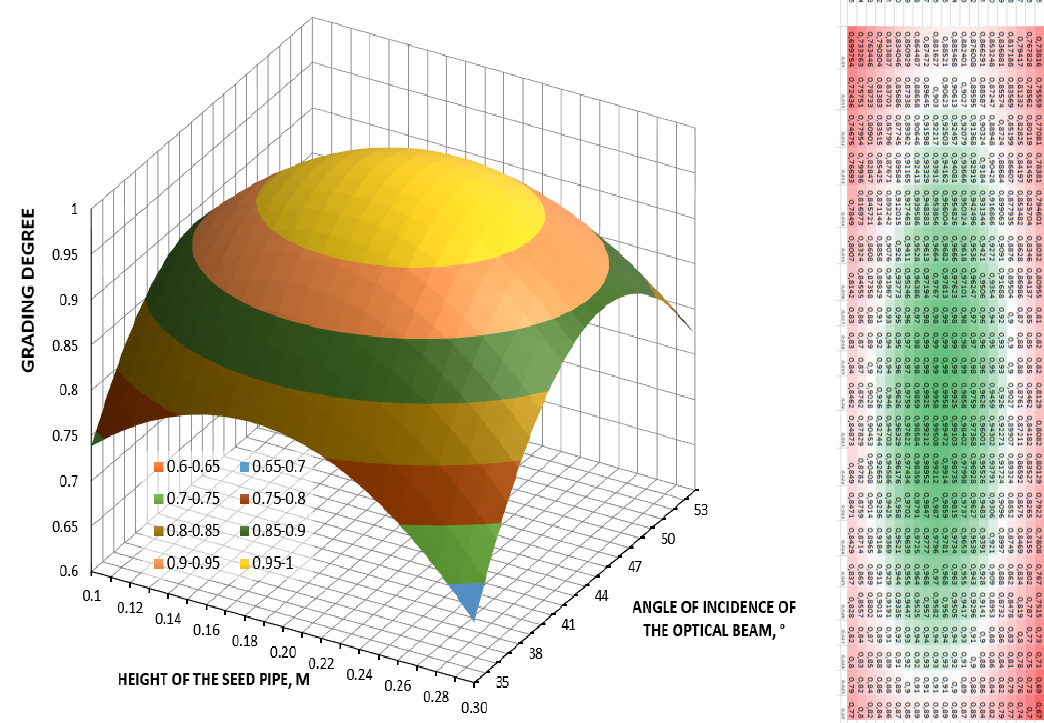
Figure 1. The response surface ( left ) and Excel–nomogram ( right ) determine the optimum when implementing a composite full–factor experiment when fixing the wavelength of the reflected radiation in the center of the plan at the level of 700 nm.